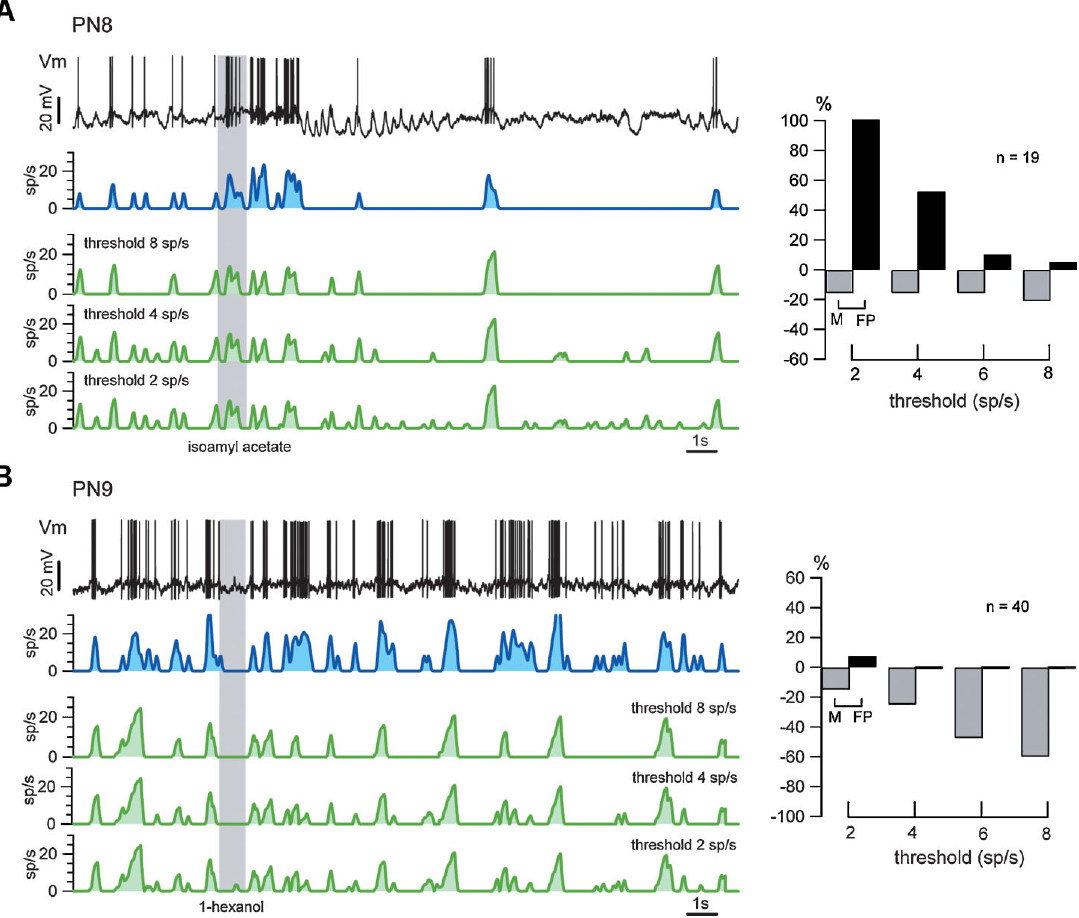
Figure 8. Empirical assessment of firing threshold value (see text) that minimizes the sum of missed and false positive events (M+FP). Different thresholds are tested (green traces) and compared with the firing rate profile (blue) measured. The PNs in A and B are chosen because they illustrate two extremes of PN activity patterns ( A : sparse firing, large subthreshold potential variations; B : high and variable resting activity). Because the threshold is a fixed parameter, it should be optimized such that reconstruction accuracy is maximized over all PNs. ( A ) Following odor presentation, PN8 undergoes many successive subthreshold potential variations, leading to a large proportion of false positive events in the prediction from ∆ F/F. A threshold of 8sp/second would be optimal for this neuron. ( B ) By contrast, PN9 displays a high and irregular spike discharge both at rest and after odor stimulation, causing very few false positive events. A high threshold, however, leads to many missed events. A threshold of 2sp/second would be optimal for this neuron. After similar analysis with several PNs, the threshold parameter was set at 4sp/second; this value represents a trade-off between missing and erroneously detecting spiking events, when assessed over a large span of PN firing